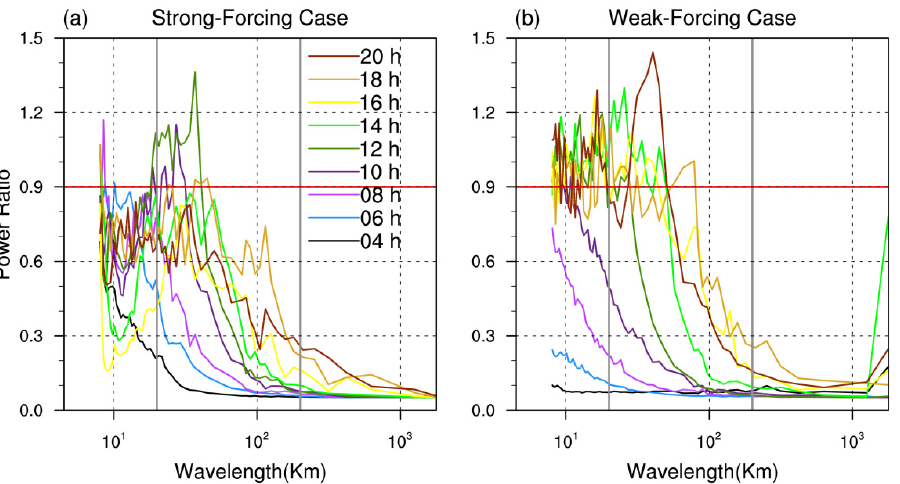
Figure 13. Spectral distribution of the power ratio (R, no unit) at different forecast lead times in the ( a ) SF case and ( b ) WF case. The gray lines along the y -axis are 20 and 200 km and the red reference lines indicate the threshold (total loss of predictability) of 0.9.